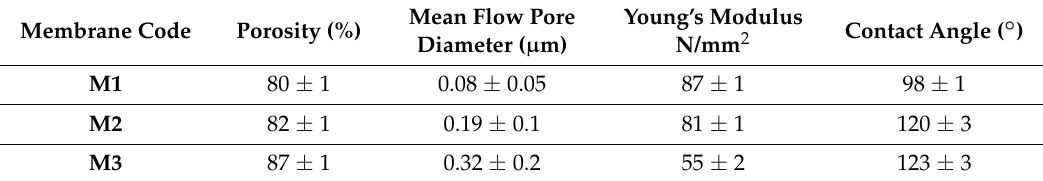
Table 1. Characterization of the M1–M3 membranes.